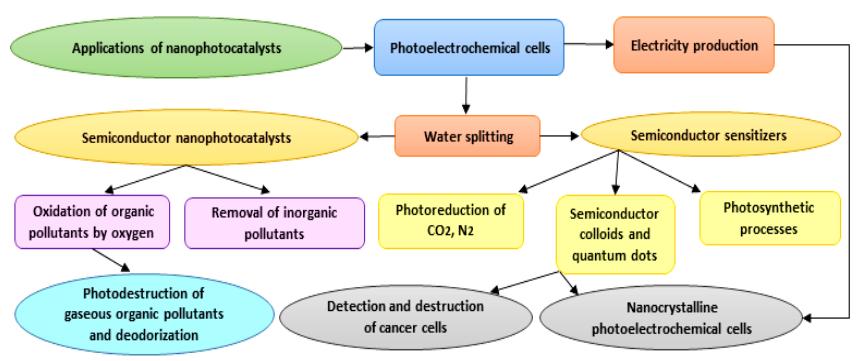
Figure 3. Diagram showing different applications proposed for nanophotocatalysts.